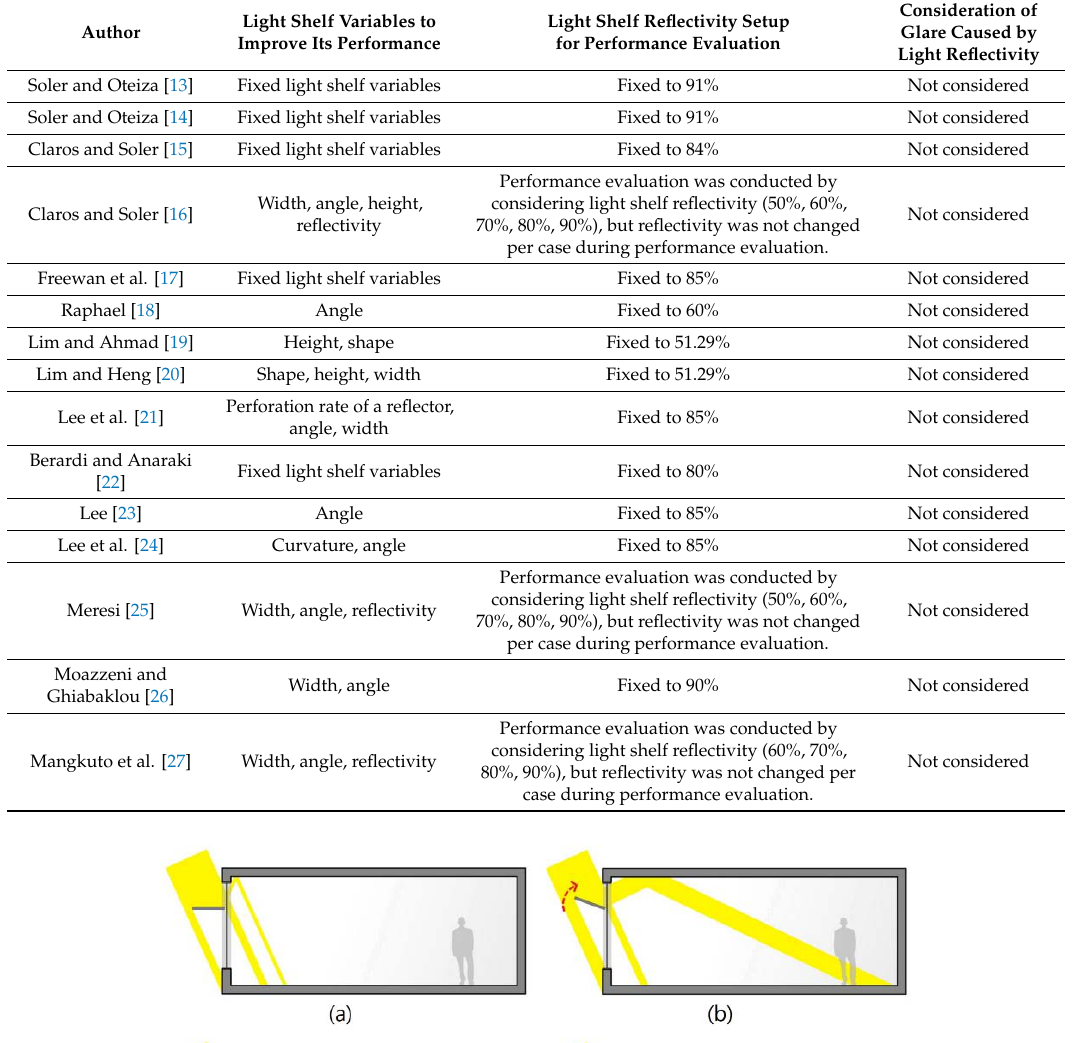
Table 1. Review of prior studies on the light shelf.